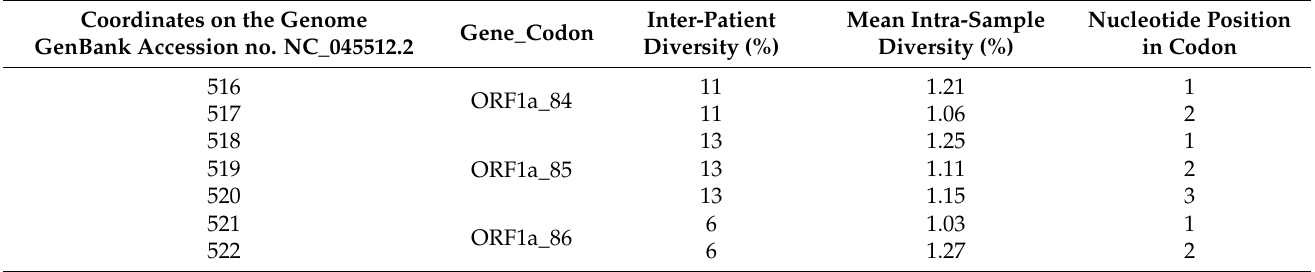
Table 2. Nucleotide positions within SARS-CoV-2 genomes exhibiting intra-sample and inter-patient